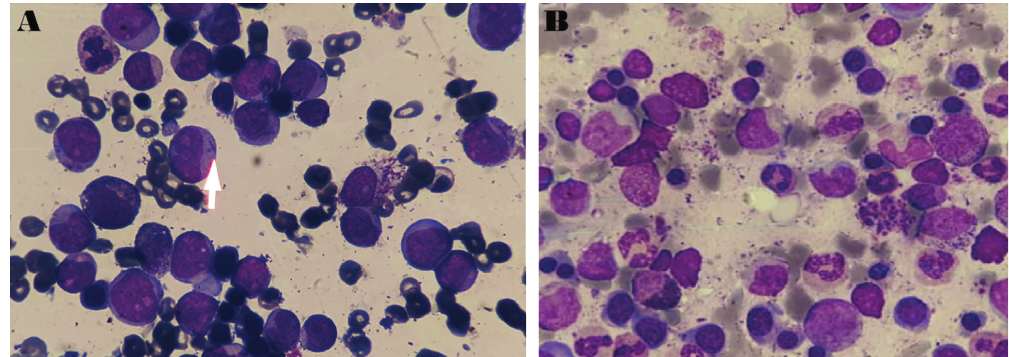
Figure 1: Bone marrow aspiration (BMA) morphology (1000 × Wright–Giemsa stain): (a) diagnostic BMA showing decreased trilineage hematopoiesis with a predominant medium-to-large-size myeloblast population with Auer rods in some blasts (arrow). (b) Follow-up BMA, after two months, showing maturing hematopoiesis with no abnormal myeloid blast population resembling complete